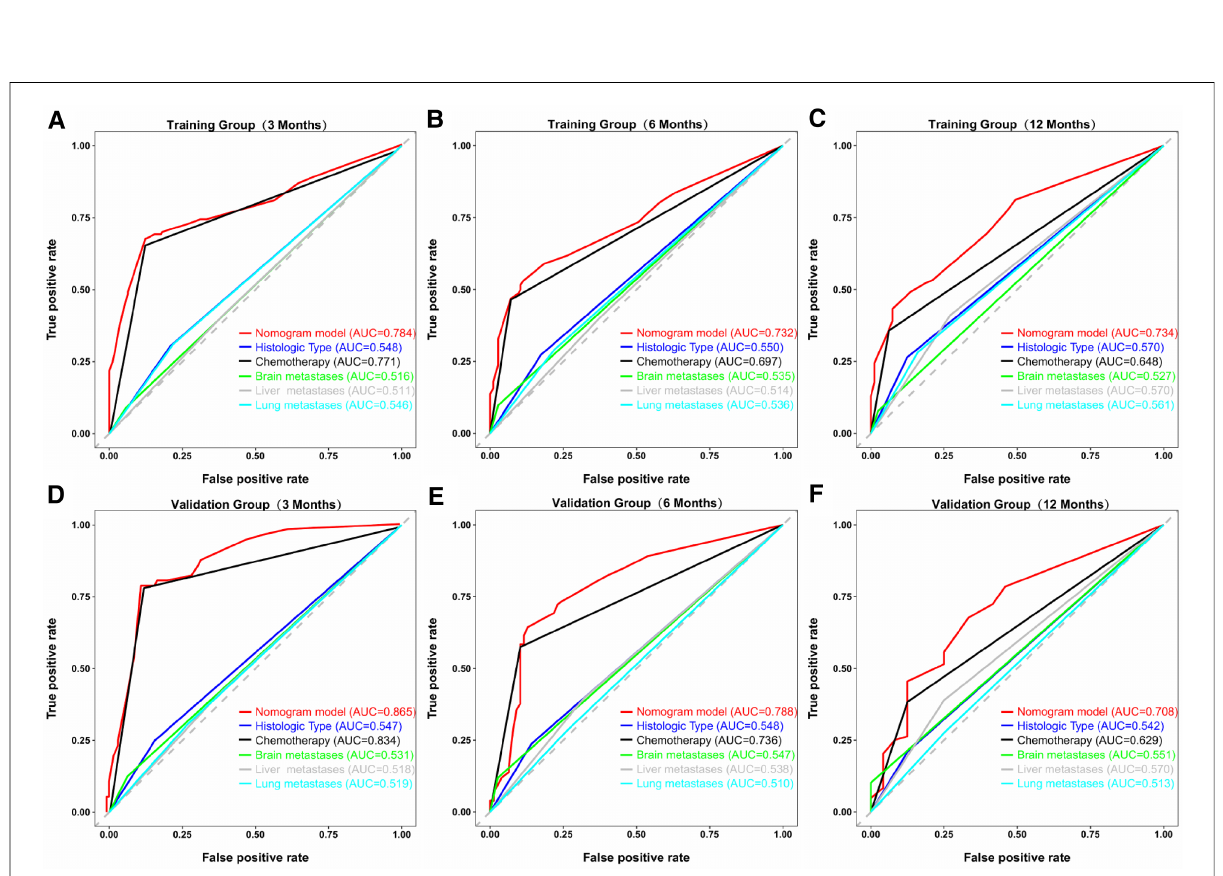
FIGURE 7 ROC curves of the prognostic model and each predictor at 3 ( A ), 6 ( B ), and 12 months ( C ) in the training group, and at 3 ( D ), 6 ( E ), and 12 months ( F ) in the validation group. The AUC values of the nomogram were larger than all single predictors at 3, 6, and 12 months in both